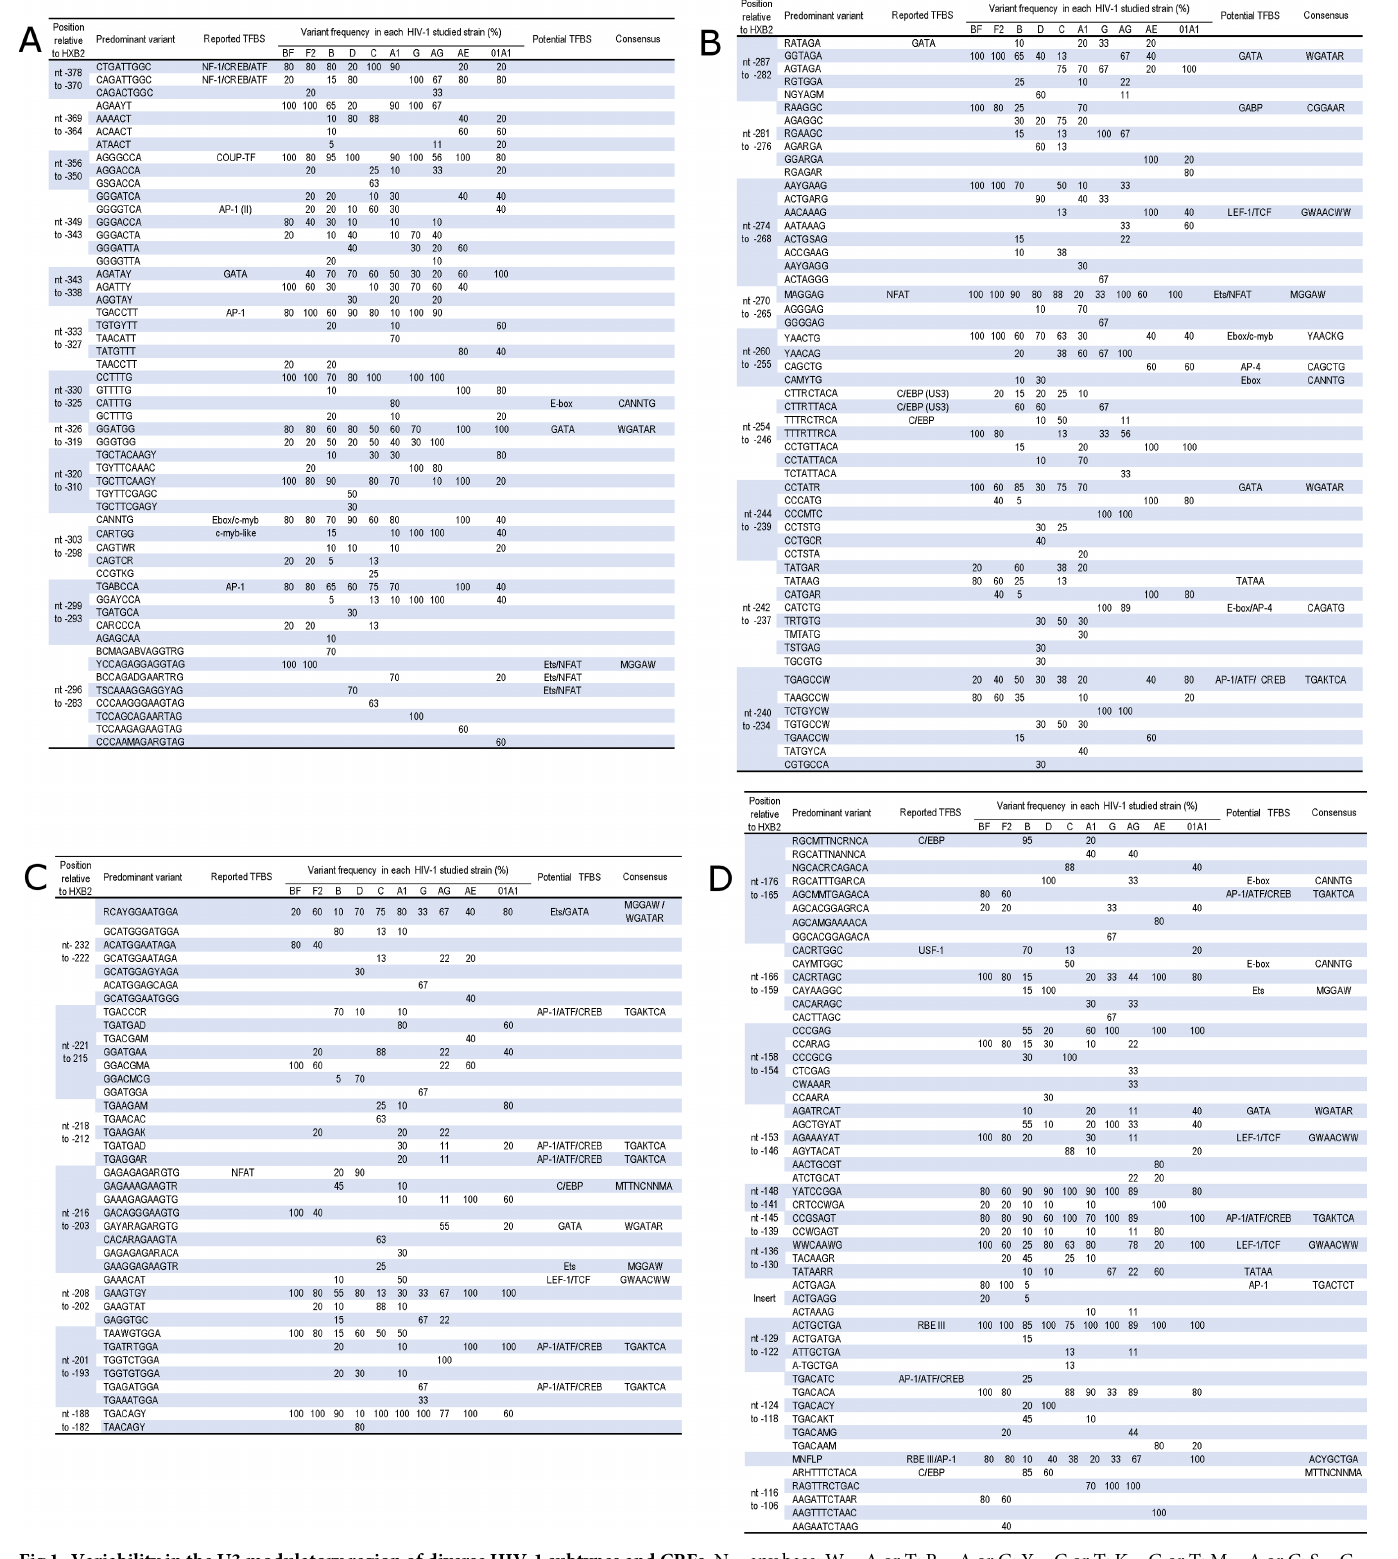
Fig 1. Variability in the U3 modulatory region of diverse HIV-1 subtypes and CRFs. N = any base; W = A or T; R = A or G; Y = C or T; K = G or T; M = A or C; S = G or C; D = A, G or T; H = A, C or T; B = C, G or T. https://doi.org/10.1371/journal.pone.0195661.g001 PLOS ONE | https://doi.org/10.1371/journal.pone.0195661 April 17,